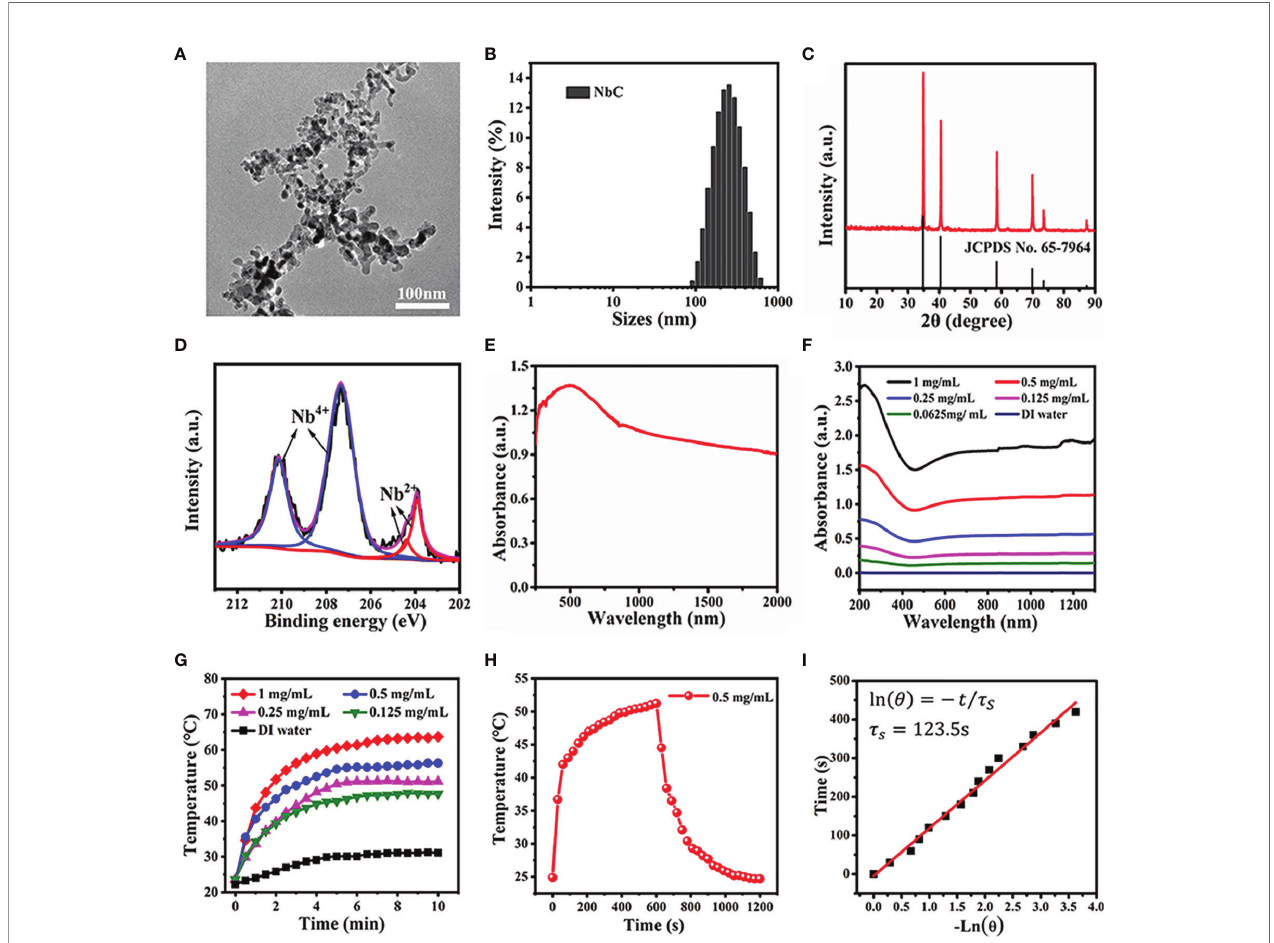
FIGURE 1 | Characterization of the NbC nanoparticles. (A) TEM image. (B) The hydrodynamic size of NbC measured by the dynamic light scattering (DLS). (C) X-ray diffraction pattern of NbC. (D) XPS spectra of Nb 3d orbit). (E) Powder absorbance of NbC. (F) Absorbance of NbC aqueous dispersion. (G) Photothermal heating curves of the NbC aqueous dispersion with different concentrations under NIR laser irradiation (808nm, 1W/cm 2 ). (H) Heating and cooling curves of NbC dispersion. (I) Plot of time versus the negative natural logarithm of the driving force